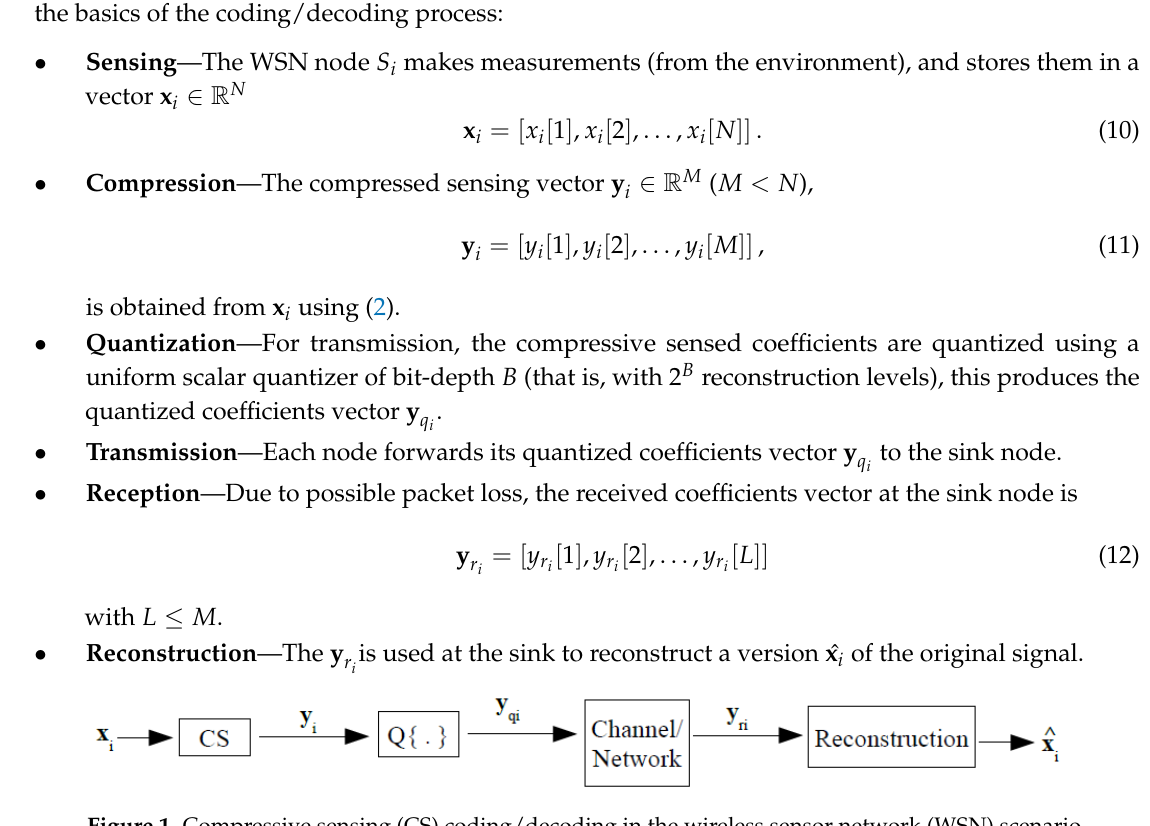
Figure 1. Compressive sensing (CS) coding/decoding in the wireless sensor network (WSN)